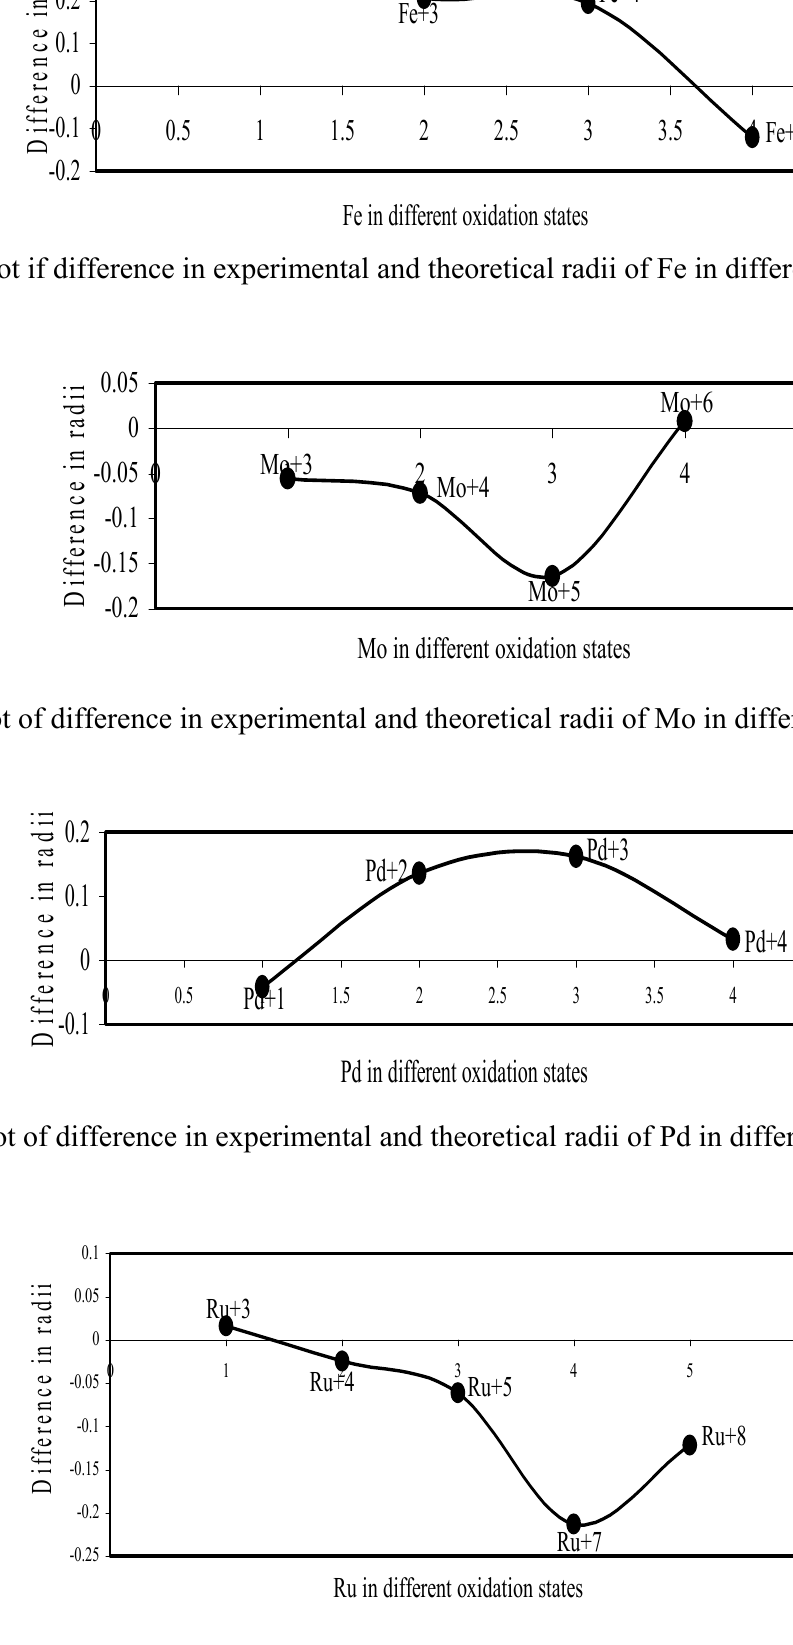
Figure 21. Plot of difference in experimental and theoretical radii of Ru in different oxidation